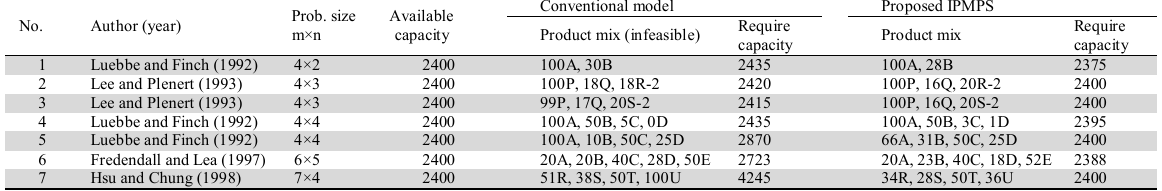
Product mix comparison of conventional model and proposed IPMPS (since the require capacity exceeds the available one, the conventional model solution is infeasible)